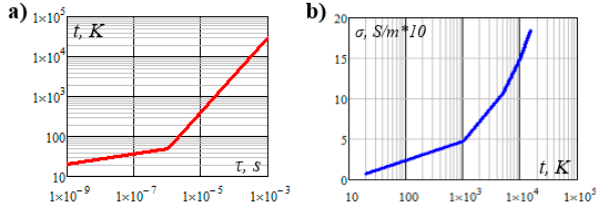
Figure 10. Plasma heating process ( a ) and characteristic of plasma conductivity vs. temperature ( b